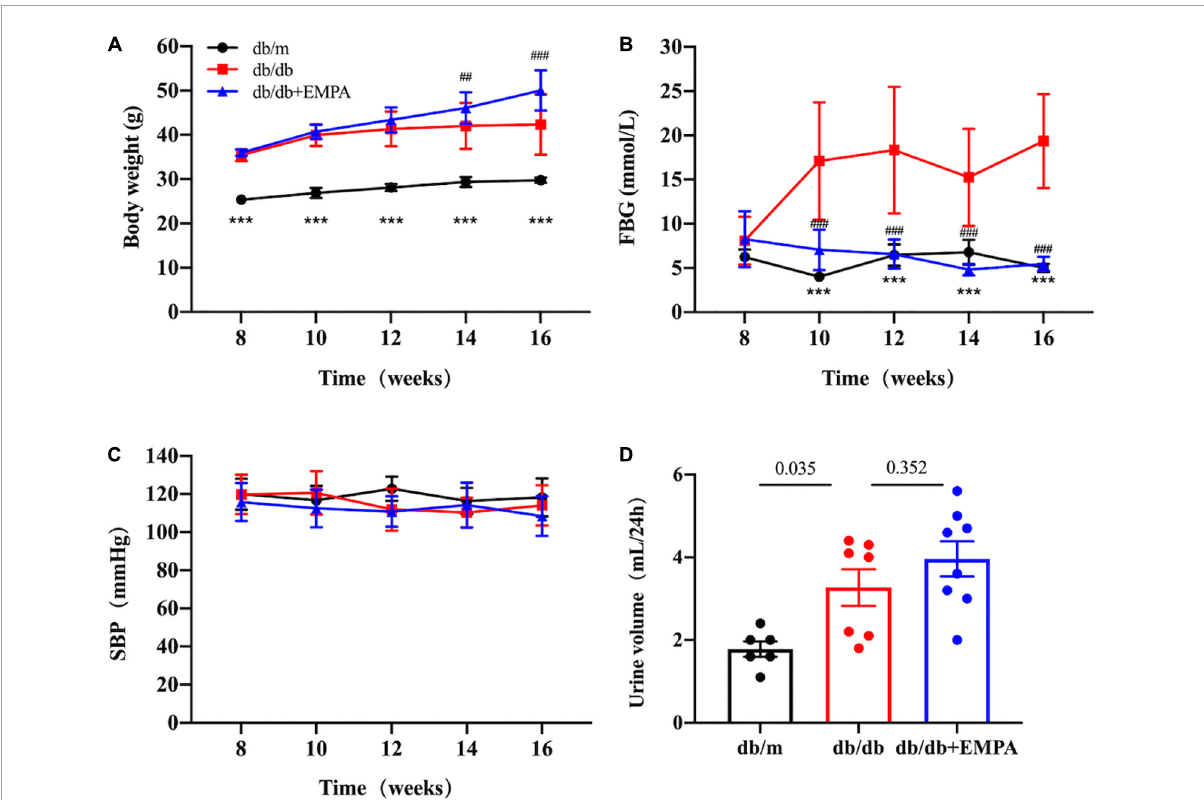
FIGURE1 Effects of empagliflozin treatment on basic parameters in different groups. Body weight, fasting blood glucose, urine volume, and systolic blood pressure of mice after different treatments from 8 to 16 weeks of age. Data are presented as the means ± SEM, (A–C) the db/m group vs. the db/db group vs. the db/db + EMPA group = 6 vs. 10 vs. 11. (D) The db/m group vs. the db/db group vs. the db/db + EMPA group = 6 vs. 7 vs. 8. *** p < 0.001, and the db/m group vs. the db/db group; ## p < 0.01 and ### p < 0.001, the db/db + EMPA group vs. the db/db group. FBG, fasting blood glucose; SBP, systolic blood